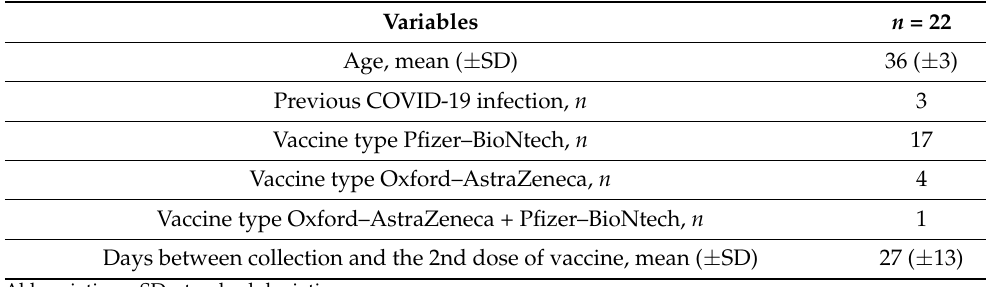
Table 1. Characteristics of the study cohort.